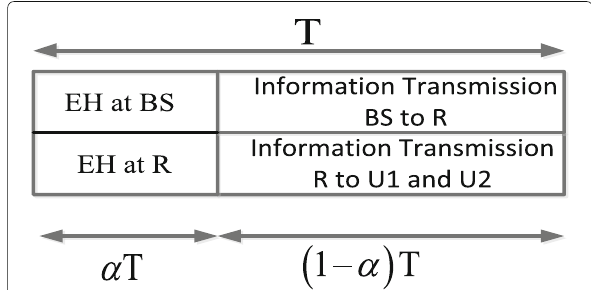
Fig. 2 An illustration of time diagram of the energy harvesting and information transmission in time block T